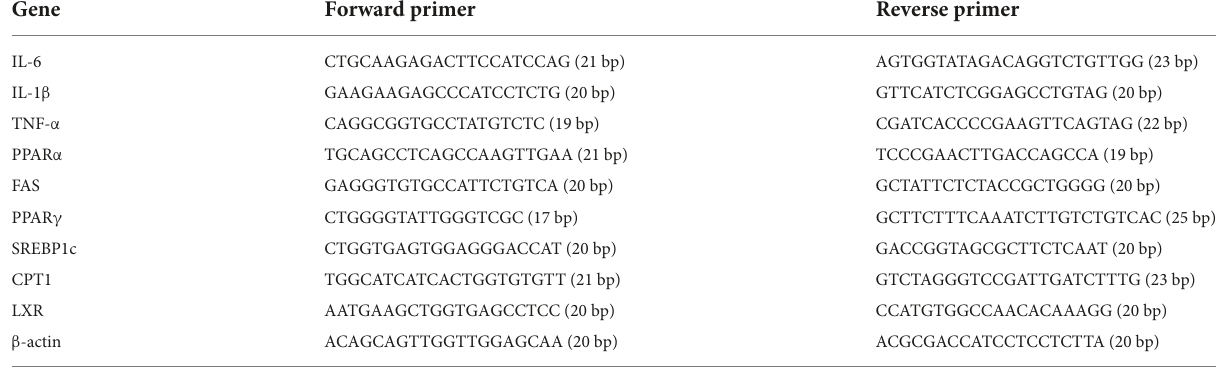
TABLE 1 Specific primer sequences used for the real-time quantitative PCR.